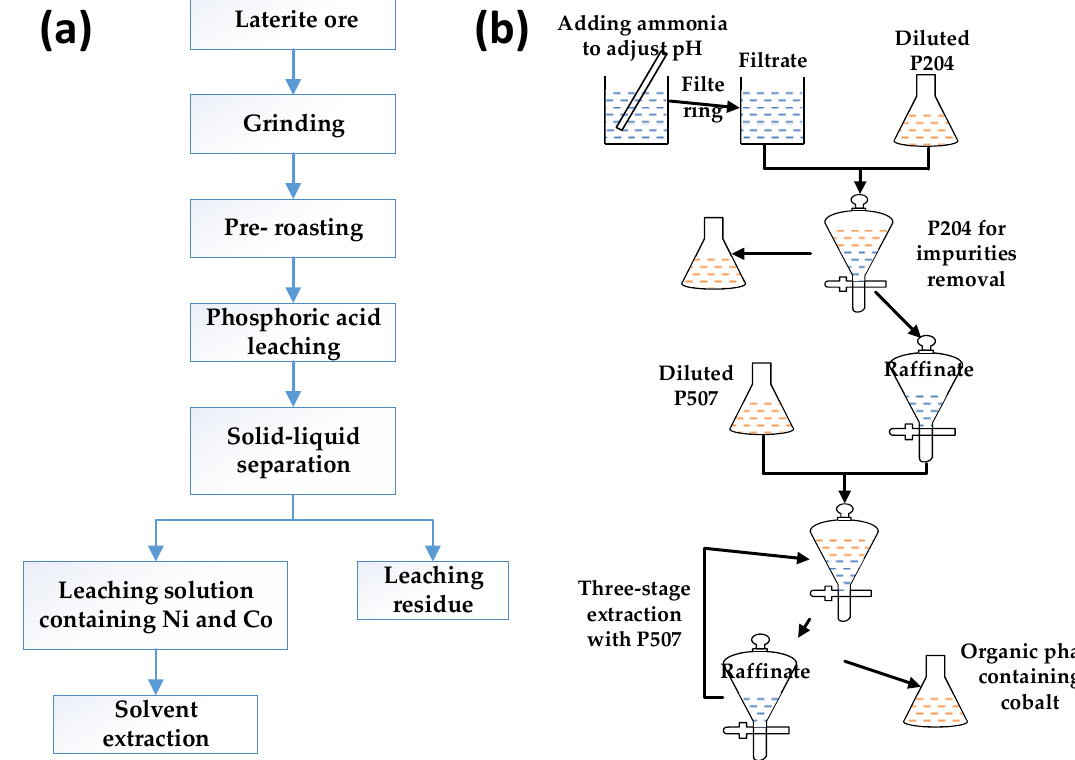
Figure 2. Experimental flowsheet: ( a ) Whole process and ( b ) Solvent extraction procedure.